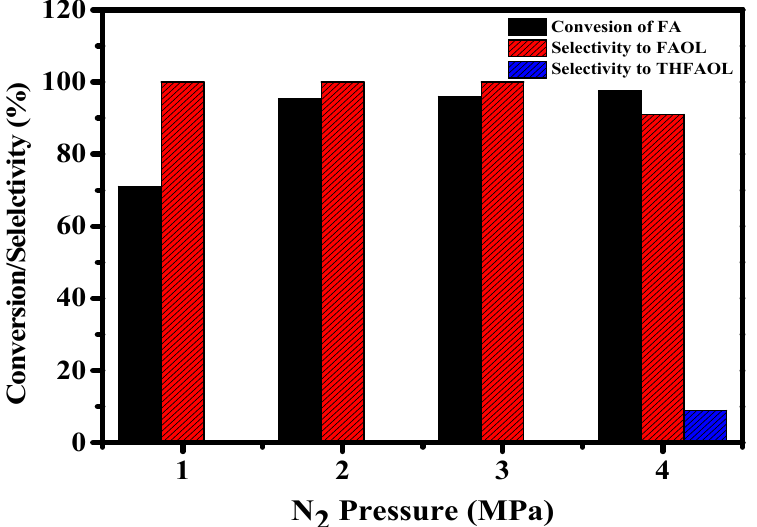
Figure 10. The e ff ect of N 2 pressure on the CTH of FA over 5CuHAp. Reaction Conditions: The catalyst Figure 10. The effect of N 2 pressure on the CTH of FA over 5CuHAp. Reaction Conditions: The amount (100 mg), 2-propanol (5 mL), FF (480 mg), reaction temperature—140 ◦ C at (1–4) MPa N 2 catalyst amount (100 mg), 2-propanol (5 mL), FF (480 mg), reaction temperature—140 °C at (1–4) MPa pressure and reaction time—4 N 2 pressure and reaction time—4 h.